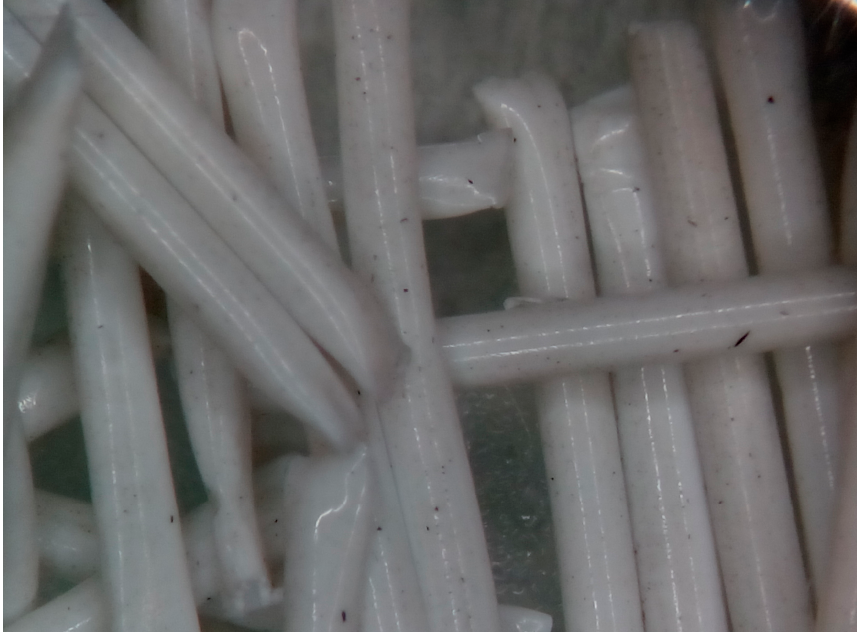
Figure 2. Optical microscopy view of ultrafilter fibers extracted from their case (Original magnification 20×).